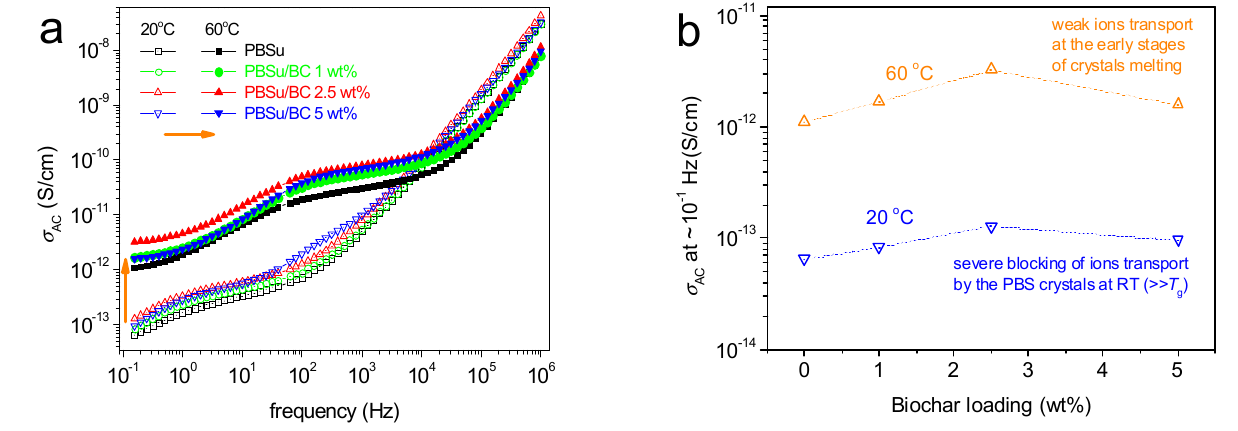
Figure 11. ( a ) Comparative isothermals of the AC conductivity, σ AC , for all samples at 20 and 60 °C. ( b ) The BC loading dependence of σ AC at the lower frequency of measurement.